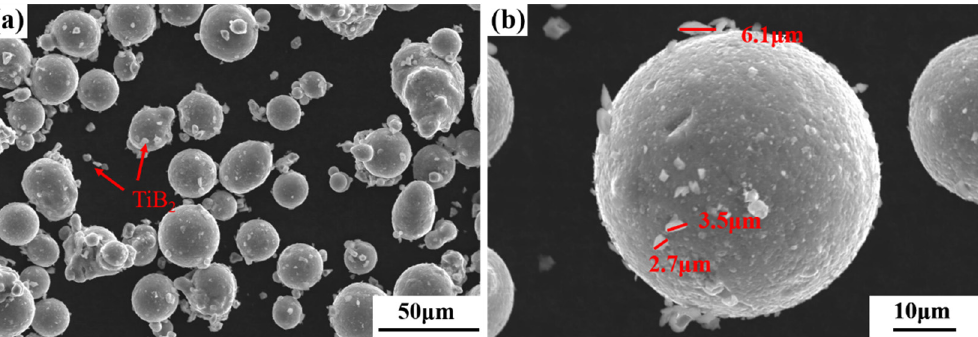
Figure 1. SEM morphology of 3 wt.% micron-sized TiB 2 /AlZnMgCu(Sc, Zr) composite powder ( a ) in relatively low magnification and ( b ) in relatively high magnification.